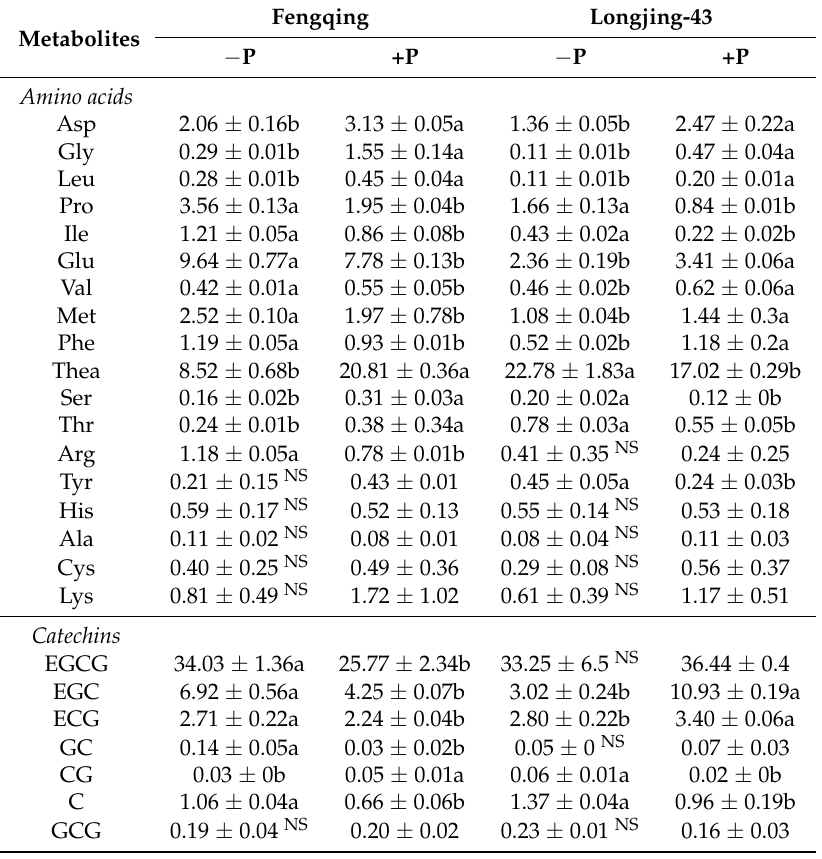
Table 3. Targeted metabolites amino acid and catechins (mg · g-1) in young shoots of tea plants supplied with two P levels in nutrient solutions.